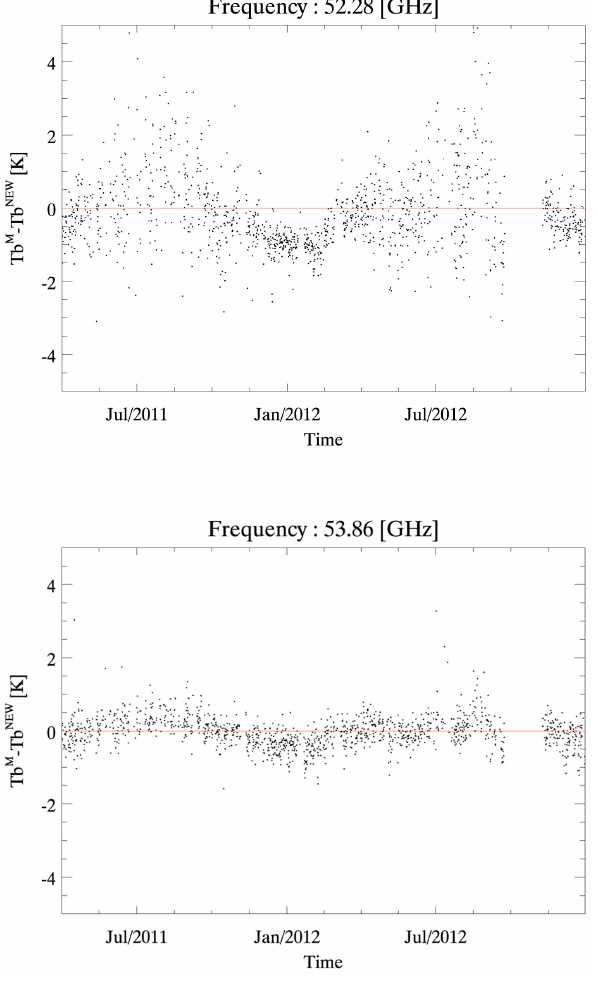
Figure 7. Time series of T M Here, the data affected by the faulty calibration period is excluded for the